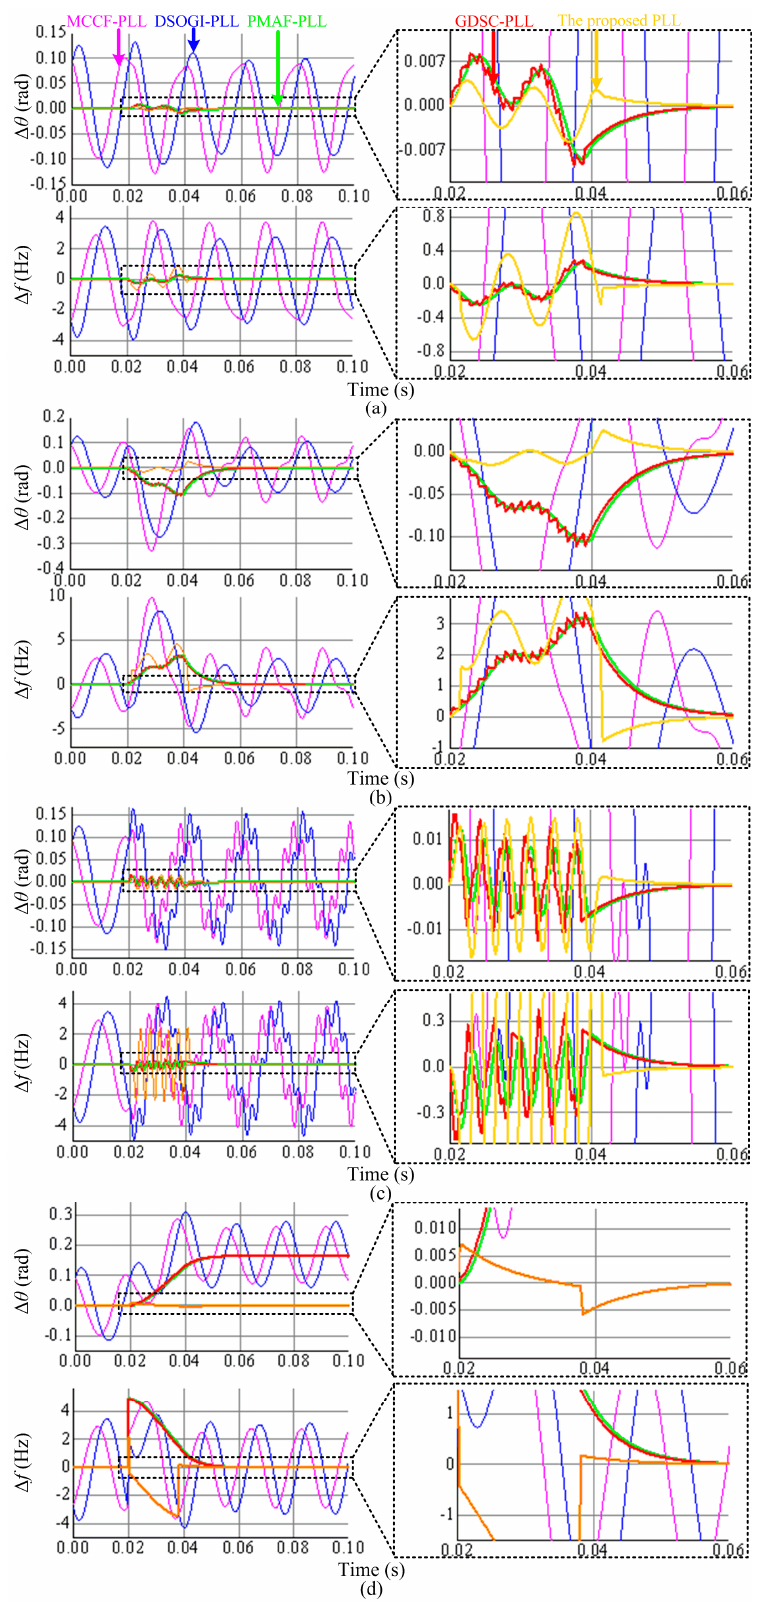
Figure 14. The comparative experimental results under conditions I–IV. ( a ) Voltage sag; ( b ) Phase jump; ( c ) Harmonics; ( d ) Step-changed frequency.